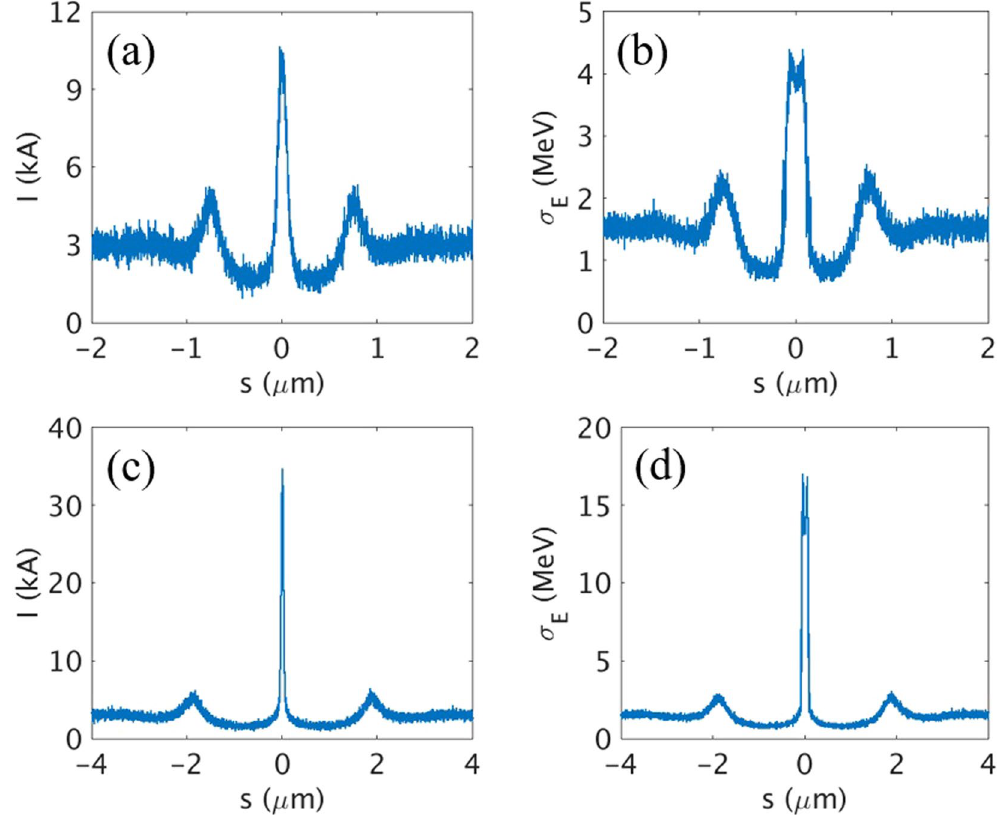
Figure 4. ( a ) Current profile and ( b ) SES profile of the electron beam for the case of single current spike with 10 kA peak current. ( c ) Current profile and ( d ) SES profile of the electron beam for the case of single current spike with 35 kA peak